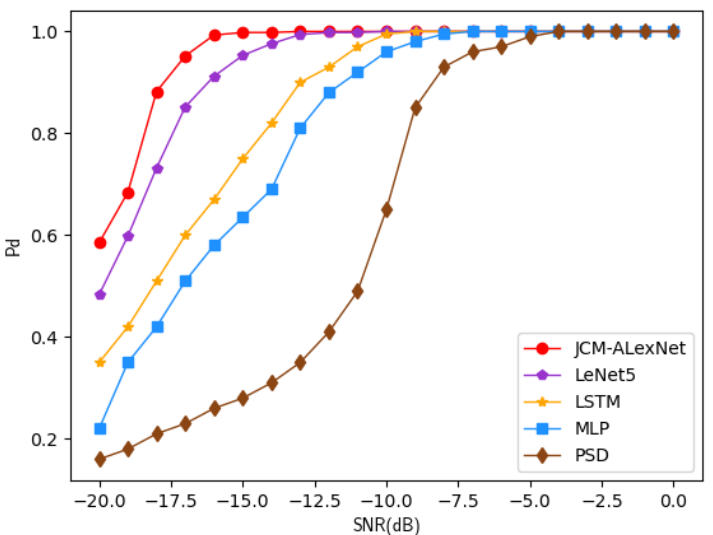
Figure 4. Pd of five algorithms with different SNRs at Pf = 0.